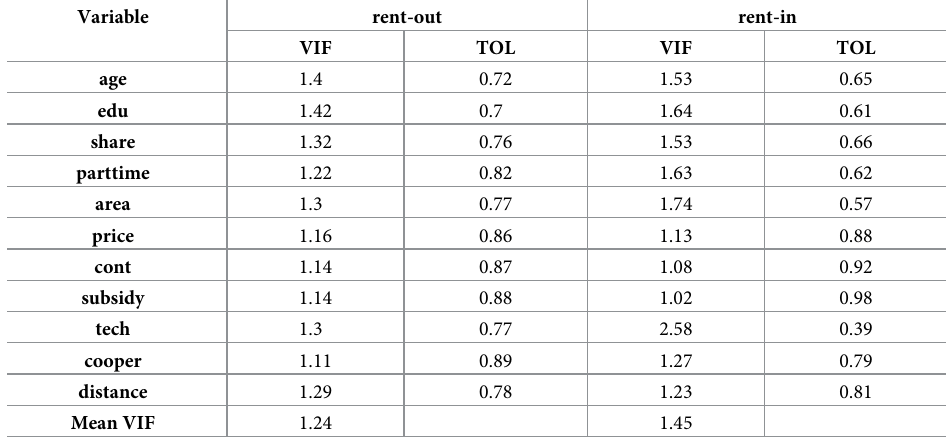
Table 3. Measurement results of variance inflation factor and tolerance of each variable.